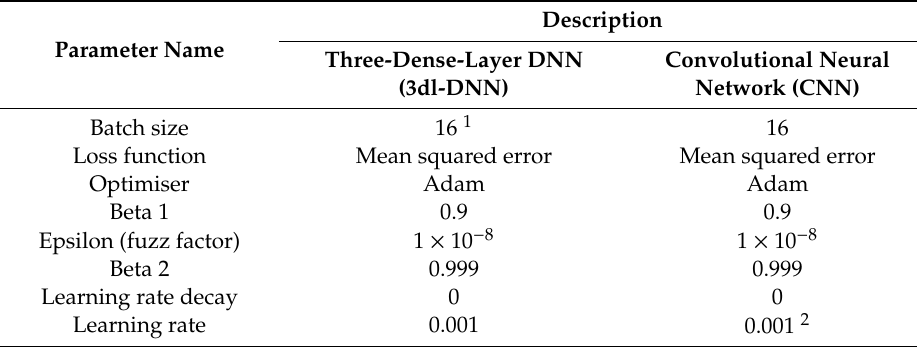
Table 4. Hyperparameters of the best deep neural networks (DNNs).